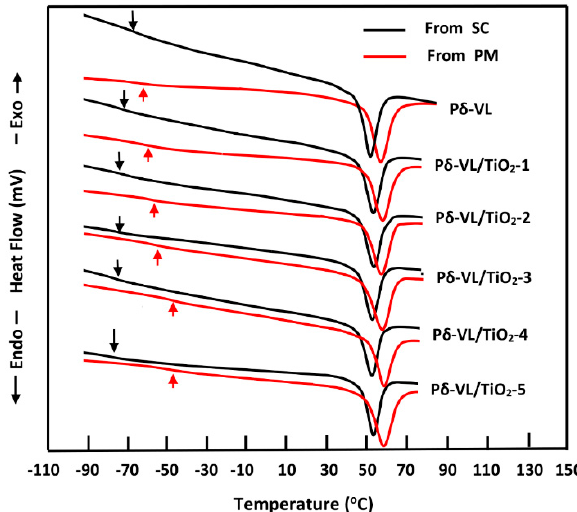
Figure 3. DSC thermograms of pure TiO 2 nanoparticles, virgin P δ -VL and P δ -VL/TiO 2 nanocomposites with different TiO 2 loads prepared differently (SC and PM methods).